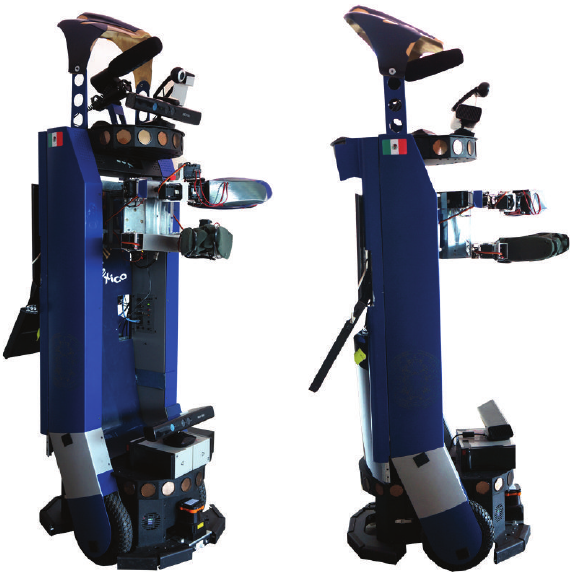
Figure 2: The Golem-II+